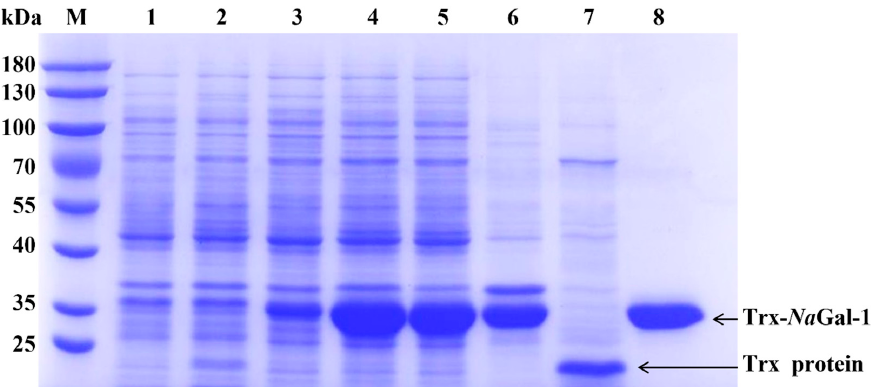
Figure 6. SDS ‐ PAGE analysis of Na Gal ‐ 1 fusion protein. Protein marker (lane M); proteins of E. coli BL21 containing control vector pET ‐ 32a , non ‐ induced (lane 1), induced by IPTG (lane 2), and puri ‐ BL21 containing control vector pET-32a , non-induced (lane 1), induced by IPTG (lane 2), and purified fied Trx protein (lane 7); proteins of E. coli BL21 containing pET ‐ 32a ‐ NaGal ‐ 1 , non ‐ induced (lane 3), Trx protein (lane 7); proteins of E. coli BL21 containing pET-32a-NaGal-1 , non-induced (lane 3), induced (lane 4) ; proteins of E. coli BL21 containing pET ‐ 32a ‐ Na Gal ‐ 1 after IPTG induction for 6 h induced (lane 4); proteins of E. coli BL21 containing pET-32a- Na Gal-1 after IPTG induction for 6 h and ultrasonically lysed (supernatant) (lane 5), and precipitation (lane 6) and purified Trx- Na Gal-1 protein (lane